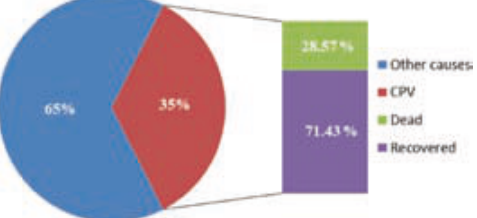
Fig. 2. Prevalence (35 per cent) and disease specific mortality rate (28.57 per cent) in dogs with CPV